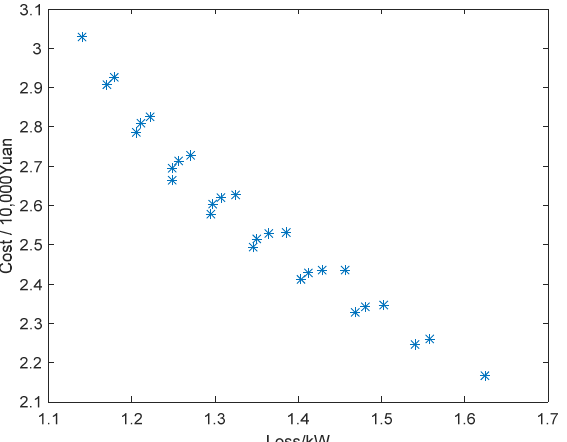
Figure 7. Distribution of the initial population in space. (An asterisk corresponds to an individual's cost and loss.)